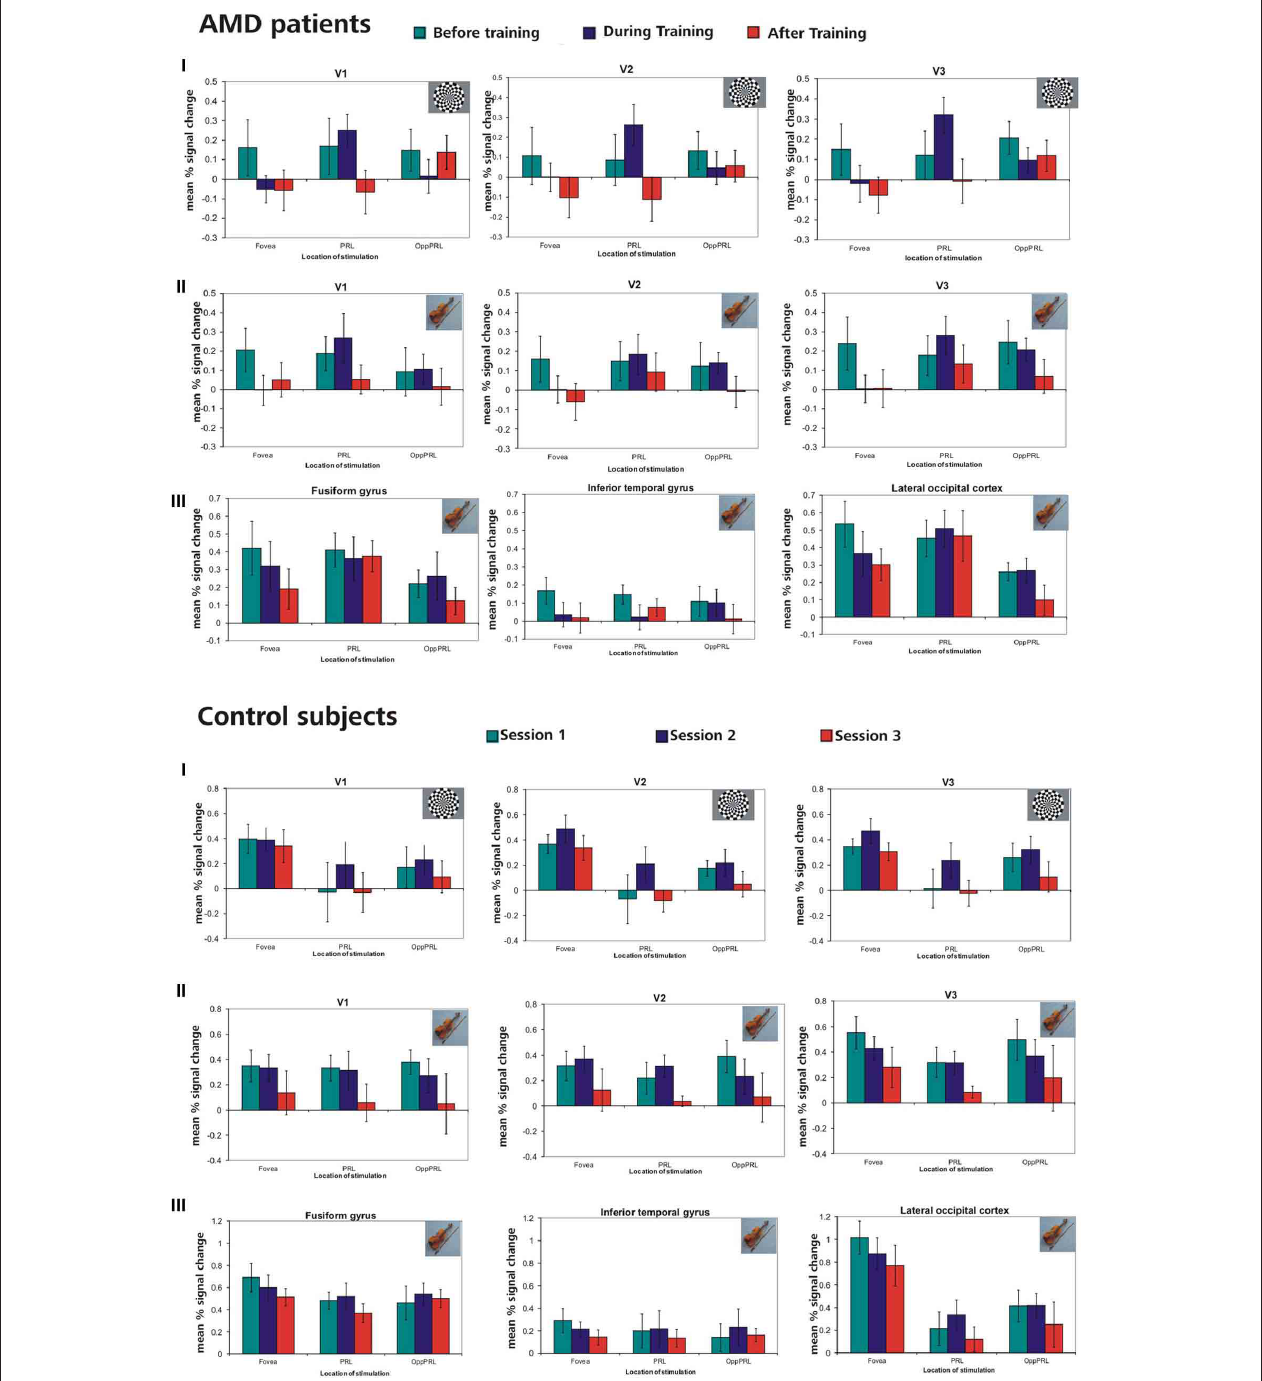
FIGURE 7 | Mean % signal changes (vs. baseline) in AMD patients and normally sighted controls before, during, and after fixation training in the individual primary (V1), secondary (V2), and tertiary (V3) visual cortex and in the anatomically predefined higher visual areas in the inferior temporal gyrus (ITG), the lateral occipital cortex (LOC), and the fusiform gyrus (as labeled in Freesurfer). The stimuli were either checkerboards (I) or meaningful pictures (II, III). For checkerboards % signal change is only reported for the individual primary cortices because no significant activation was found in higher